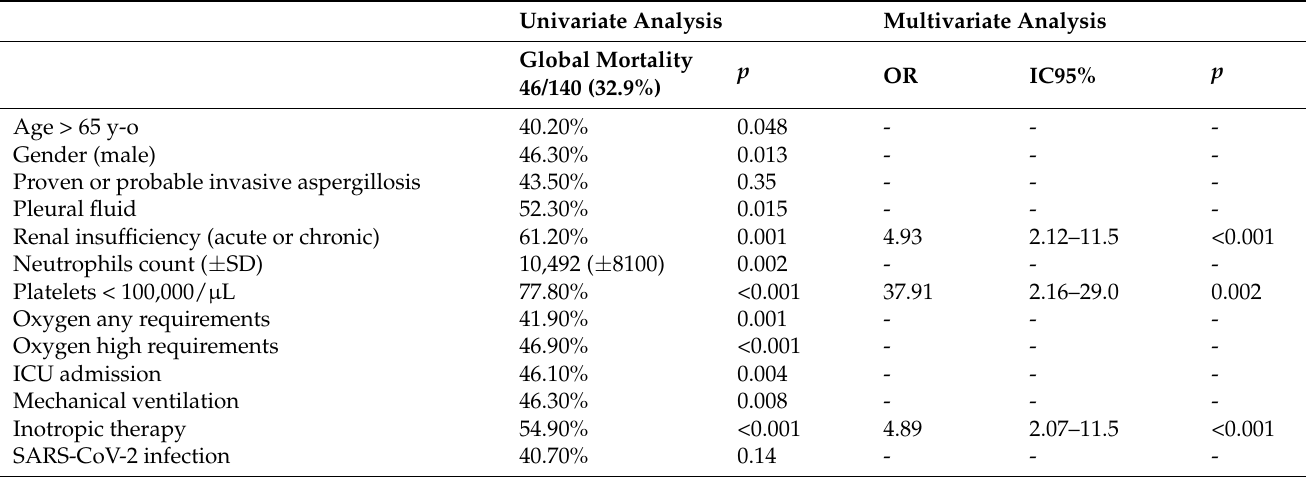
Table 4. Analysis of mortality. Uni- and multivariate analysis. Patients with IPA (proven, probable or